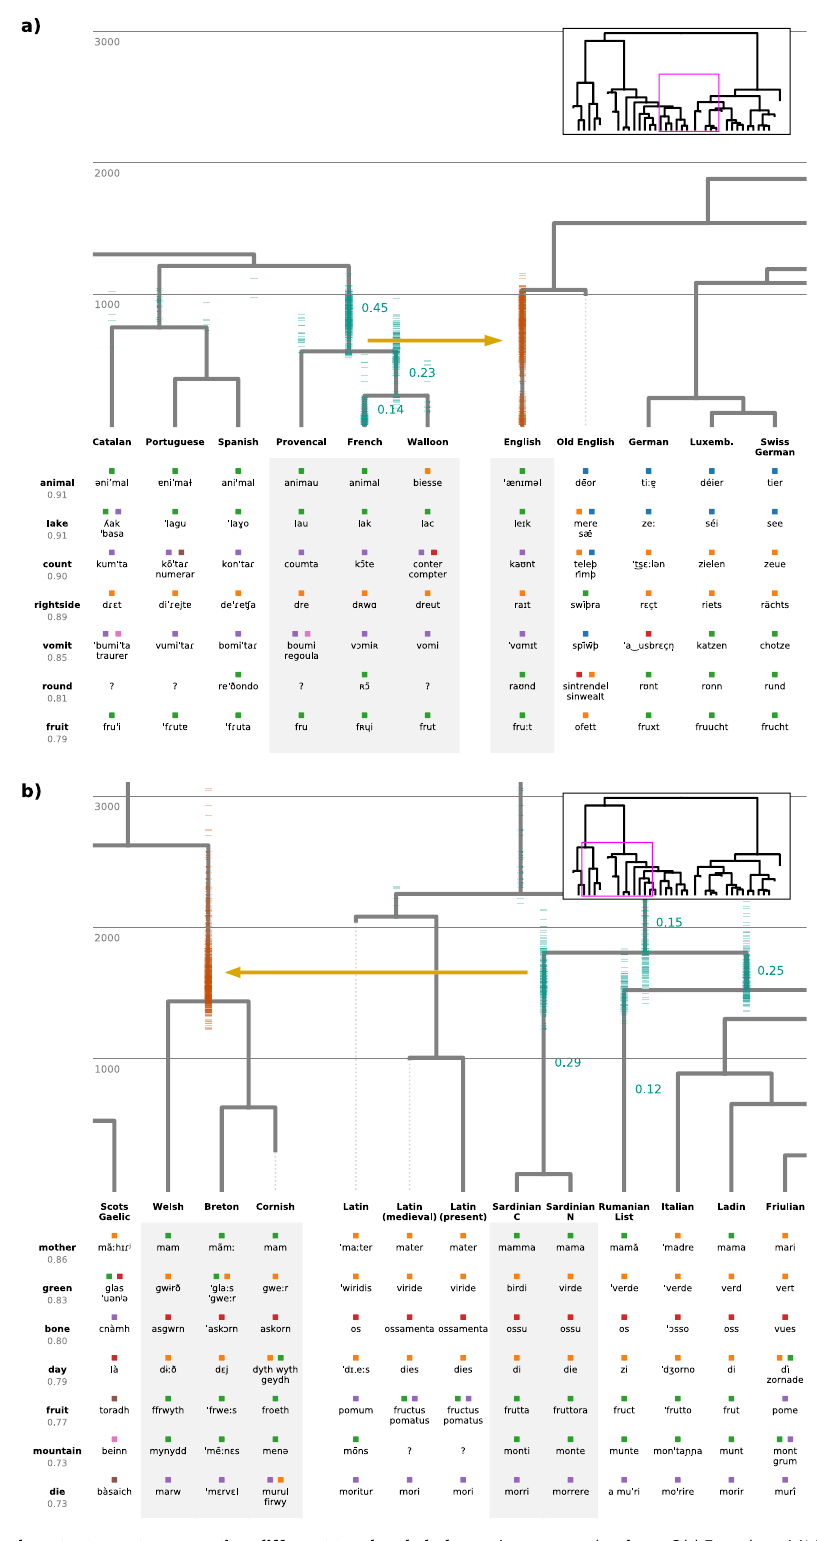
Fig. 7 The two reconstructed contact events connecting different top-level clades. a A contact edge from Old French to Middle English about 640 years before present. b A contact edge from ancestral Romance to Proto-Brittonic about 1670 years before present. Green and red marks represent the possible placements of the donor and receiver language, respectively. The word list shows the most likely loanwords at these contact events. The row labels show the meaning class and the posterior support. Each cell lists the lexemes, colorcoding the